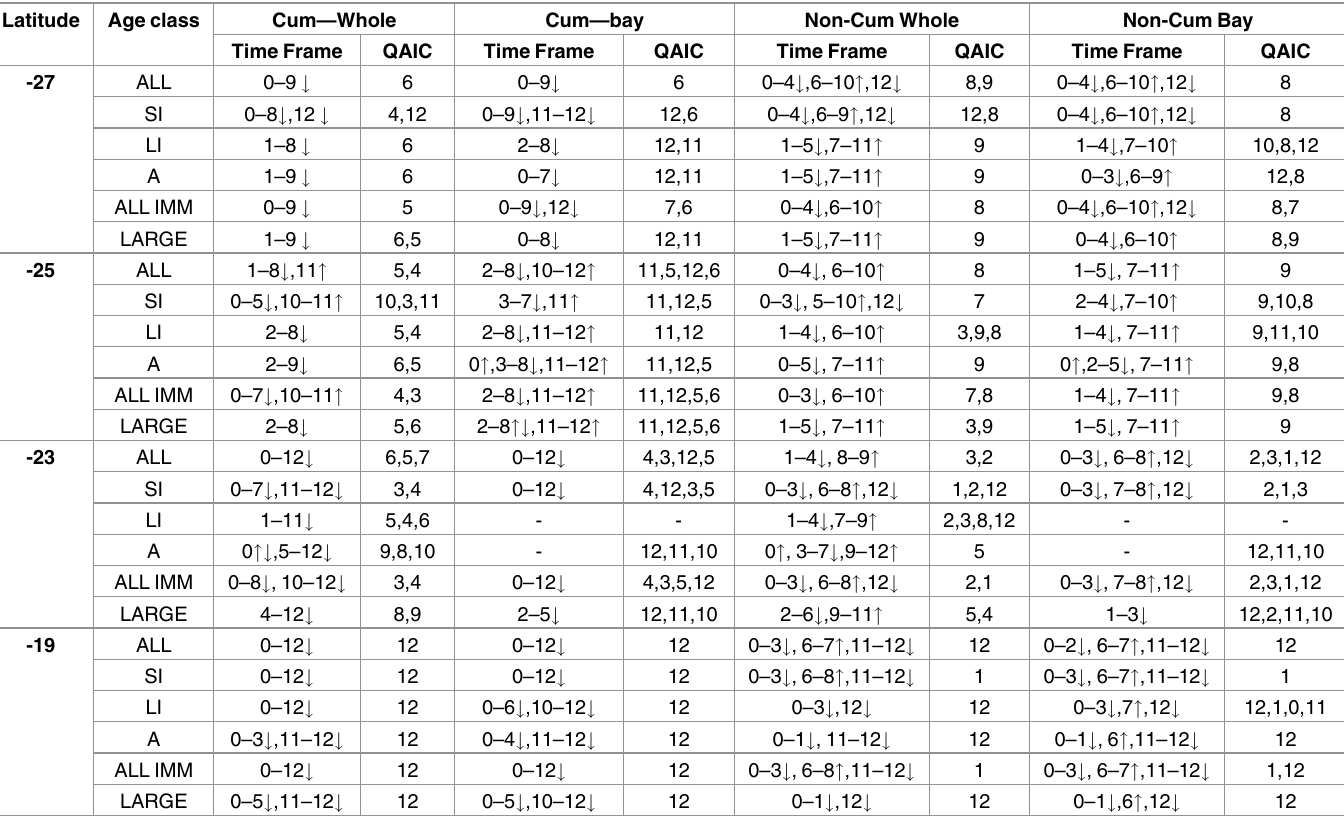
Table 6. Model results for green turtles and monthly mean maximum air temperature. " denotesincreasedstrandingsrates with increasedmean maxi- mum air temperature. # denotesdecreased strandingrates with increasedmean maximum air temperature. Age class abbreviations: ALL = all turtles, SI = small immature, LI = large immatures, A = adult-sized, ALL IMM = all immature sized animals(small + large), Large = all large turtles (large immatures + adult-sized).The time frame is reportedin monthly ranges where responses were noted. The values reportedin qAIC are the months with the most signifi- cant qAIC